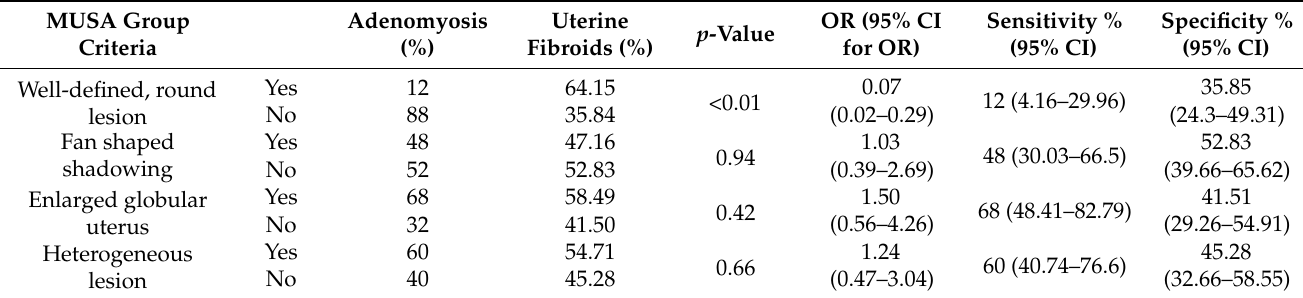
Table 3. Chi square tests for assessment of association between frequency of commonly encountered MUSA group criteria and histological results. Legend: CI = confidence interval, MUSA group = Morphological Uterus Sonographic Assessment Group and OR = odds ratio.